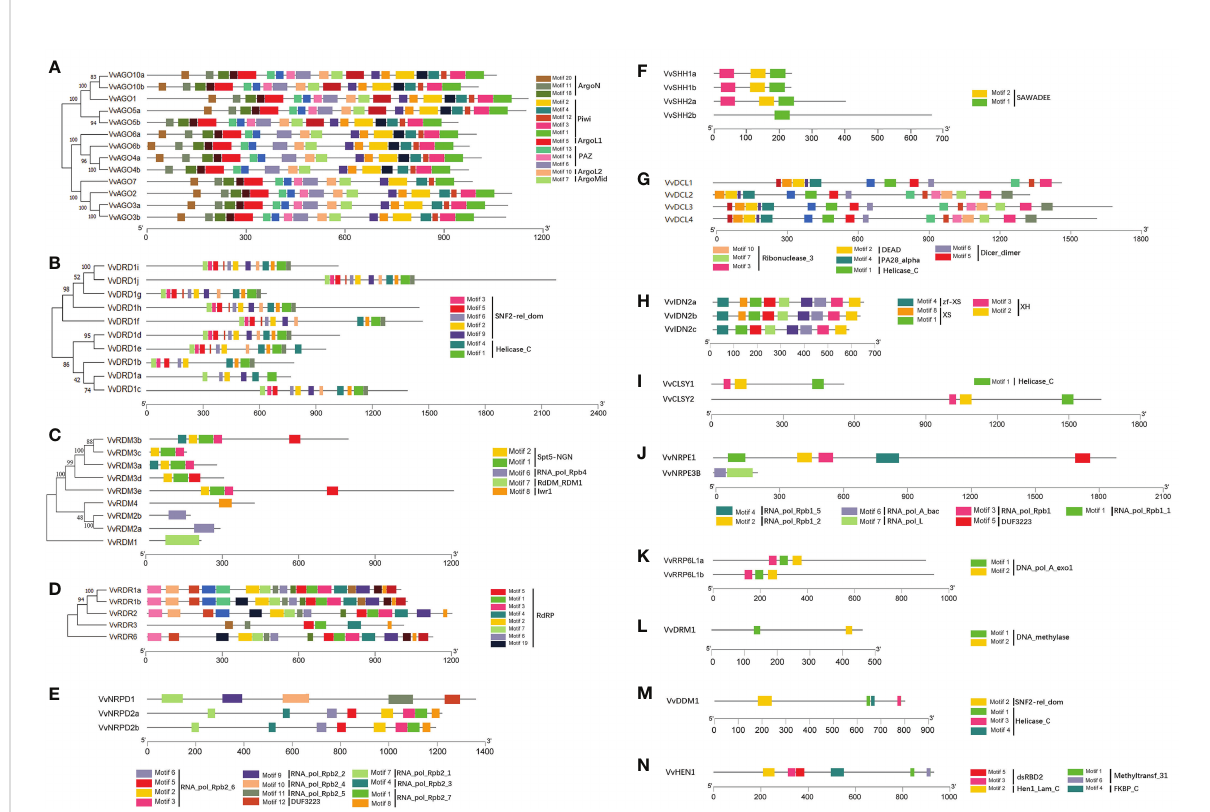
FIGURE 3 Conserved motifs analysis of VvRdDM genes. Different color boxes represent different motifs The letters (A – N) represent the different